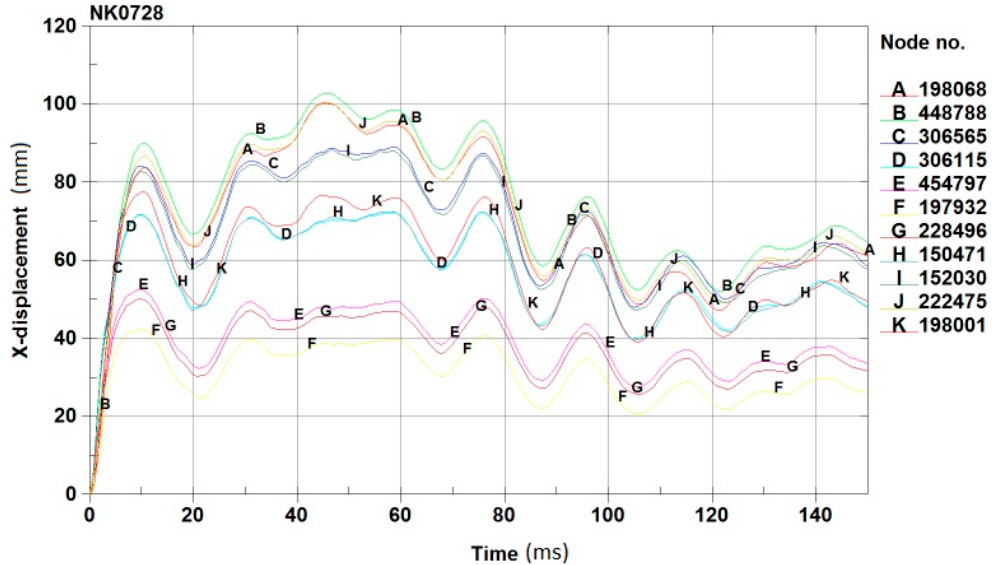
Figure 11. Diagram of displacement over time at selected points of the structure for an impact in the center of the cage.